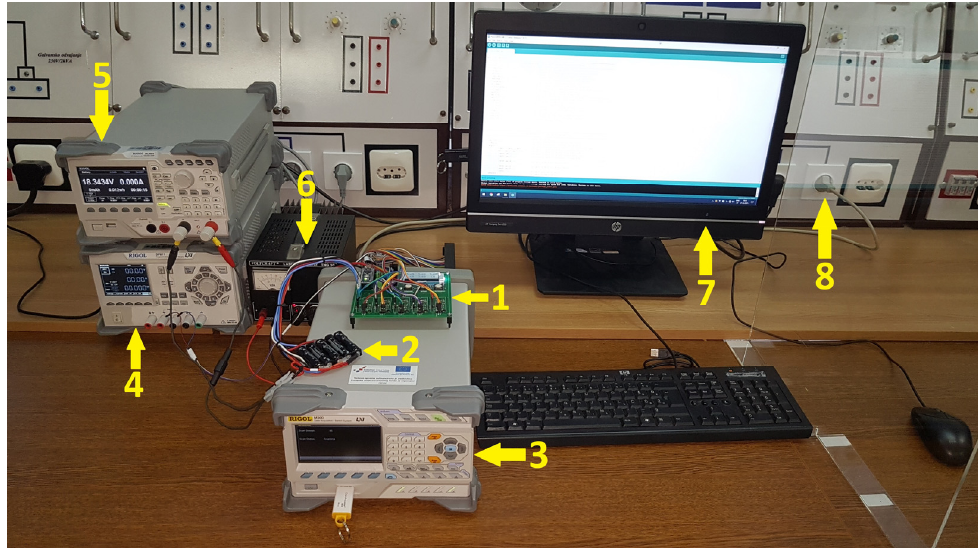
Figure 12. Experimental workbench setup.